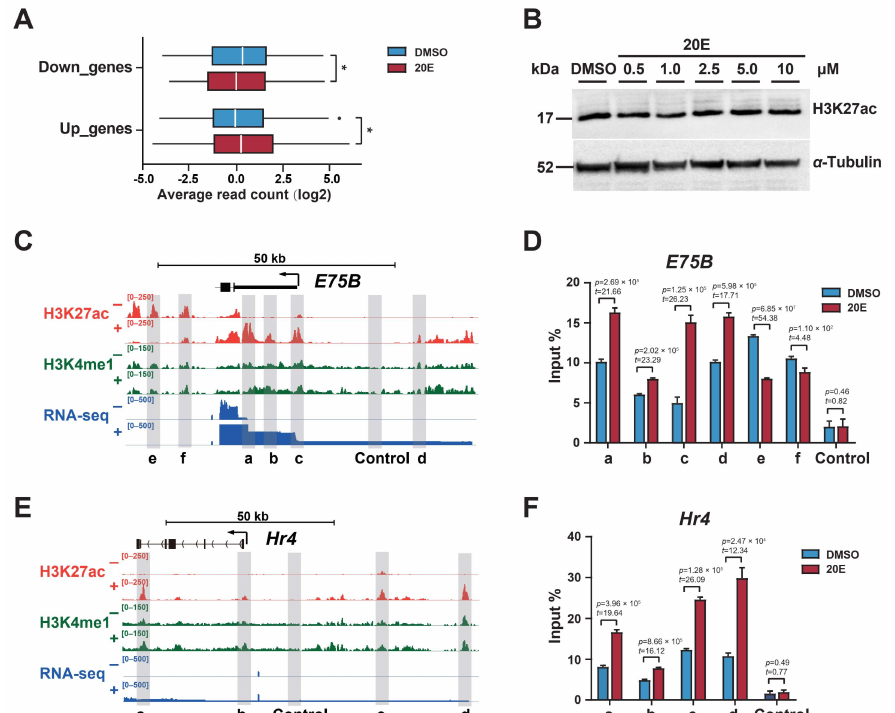
Figure 1. Ecdysone induced dynamic changes in local H3K27 acetylation. ( A ) Changes in H3K27 acetylation ChIP-seq signals for the differentially expressed genes (log 2 scale). The differentially expressed genes (“Up_genes” and “Down_genes”, respectively) were defined as those with at least a 1.5-fold change in expression after 20E treatment. * p < 0.05; Student’s t -test. ( B ) Western blotting of H3K27 acetylation levels in dimethyl sulfoxide (DMSO) or 20Etreated BmE cells. The antibodies used are shown on the right. ( C ) and ( E ) show the IGV genome browser screenshots of ChIP-seq and RNA-seq tracks for the E75B and Hr4 gene loci. Grey shading highlights putative enhancer regions. Control regions lacking enhancer chromatin were also chosen from the gene loci. + and − indicate the presence and absence of 20E treatment, respectively. ( D ) and ( F ) show the ChIP-qPCR analysis of H3K27 acetylation in DMSO or 20Etreated BmE cells. DNA was quantified using primers designed to amplify the putative regulatory elements of the E75B and Hr4 gene loci shown in ( B ). Error bars: standard errors of the mean (SEM) from three biological replicates measured in duplicate. Student’s t -test (t = 2.78, df =